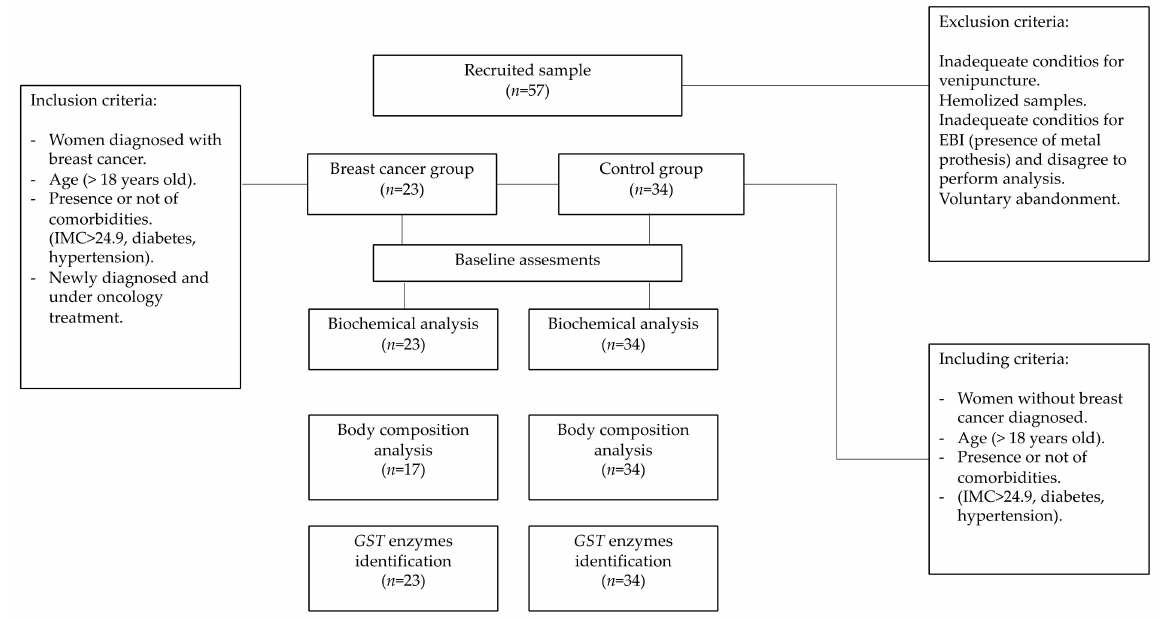
Figure 1. Study design and sample